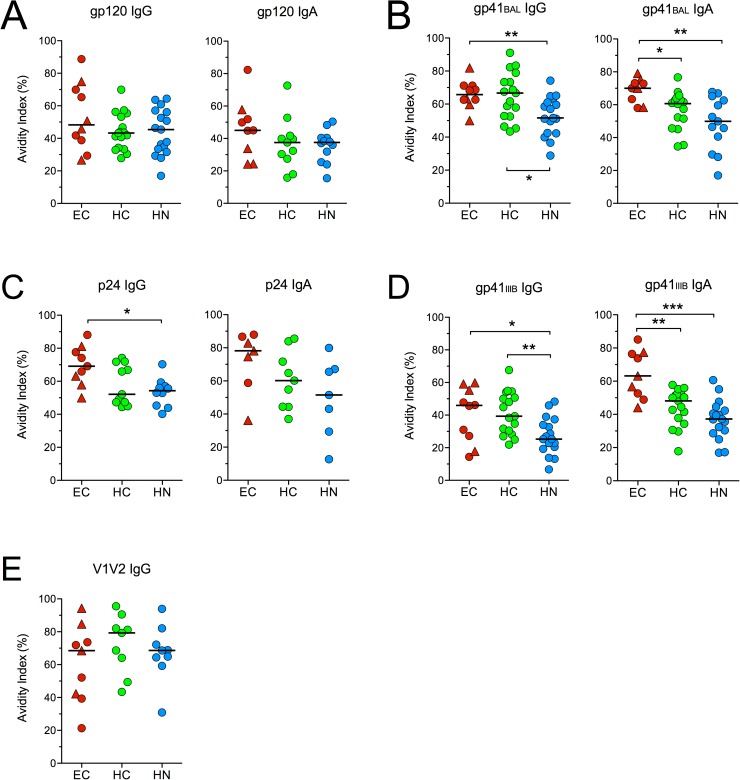
Avidity of HIV-specific IgG and IgA antibodies.The average avidity of serum IgG and IgA antibodies to (A) gp120consensus B, (B) 293T-derived gp41BAL, (C) p24, (D)
E. coli-derived gp41IIIB and (E) gp70-V1V2Case A2 at T1 and T2 is shown for subjects that had levels of binding antibodies that produced absorbance values > 0.5 at a 1/50 (for IgA) or 1/100 (for IgG) dilution. Bars represent medians. *p < 0.05, **p < 0.01 or ***p < 0.001 by two-tailed Mann-Whitney rank sum test.